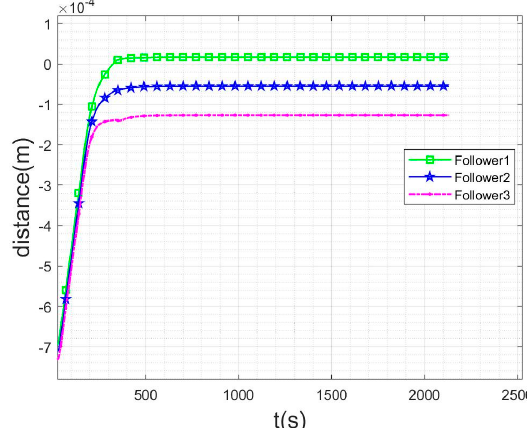
Figure 13. Relative distance between leader and followers.